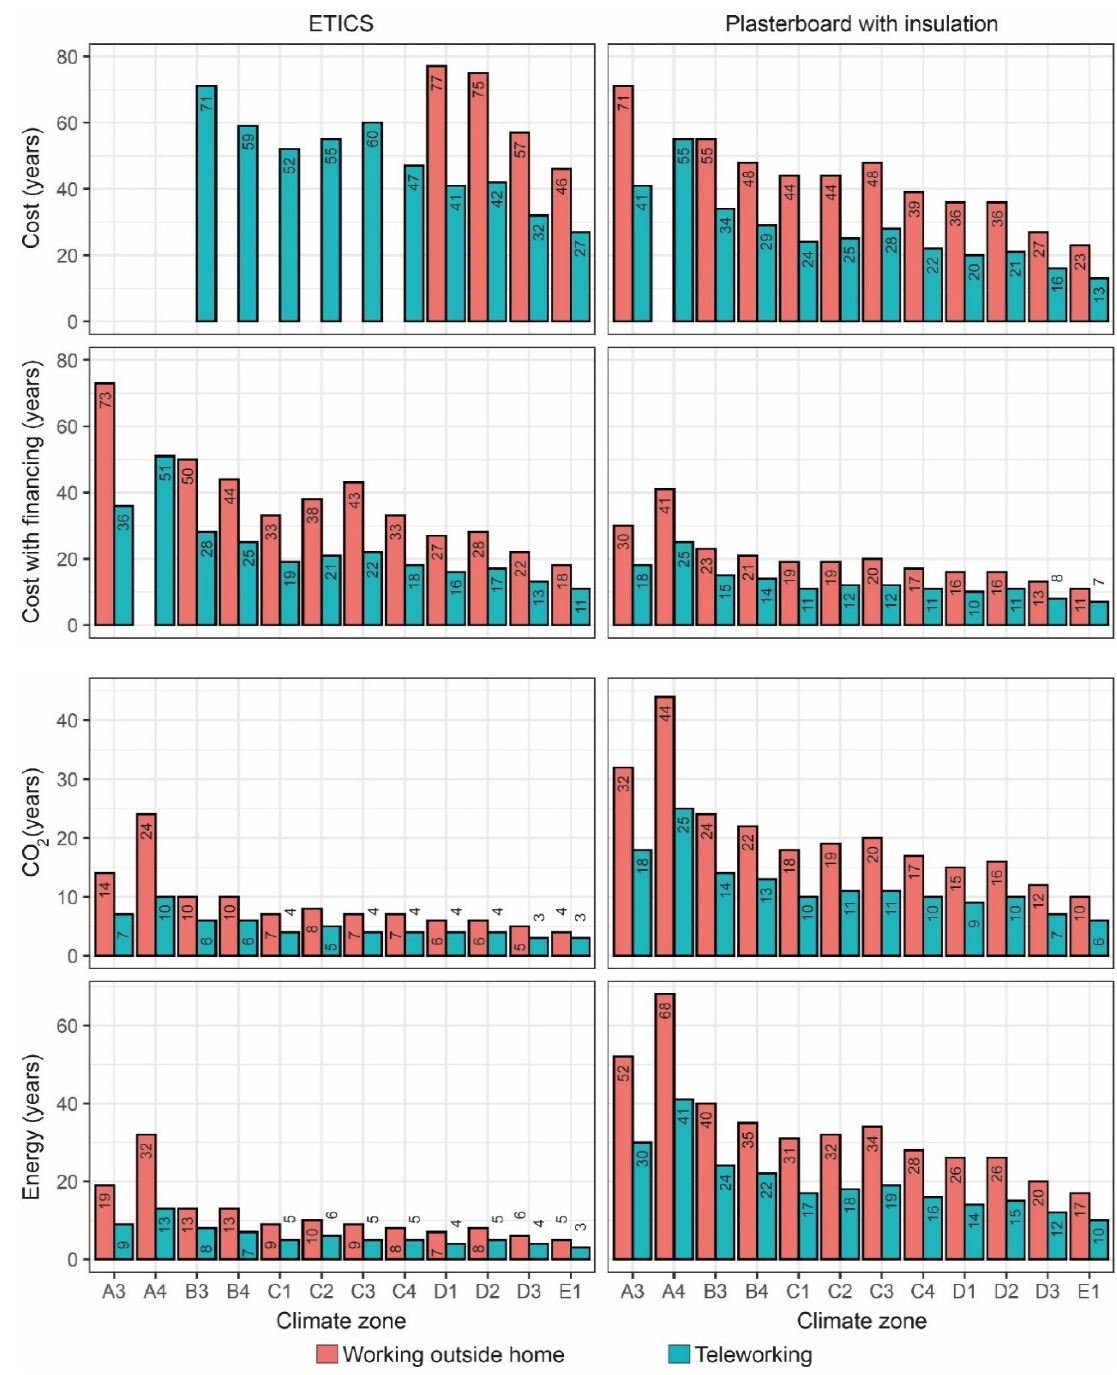
Figure 10. Periods of economic recovery, carbon dioxide emissions, and the energy related to the implementation of the ECMs. Whether the cost of the ECMs is conducted with or without financing is distinguished in the economic recovery period. Likewise, the graphs show the influence of the operational pattern of the user on recovery periods (working outside the home or teleworking).